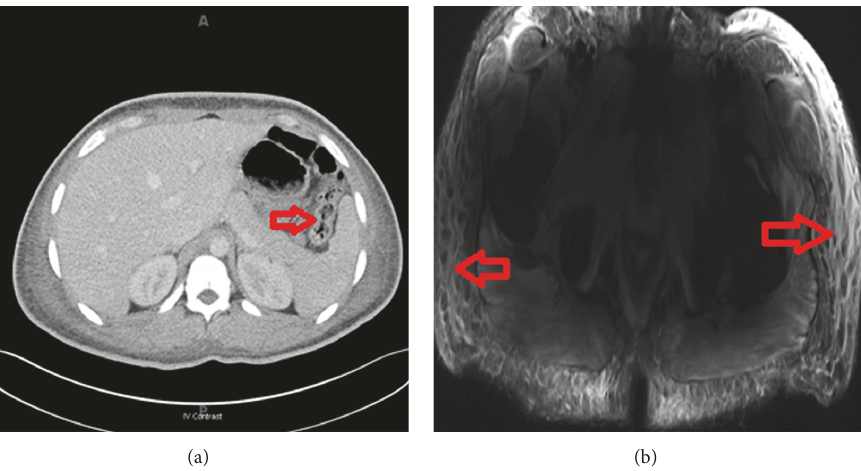
Figure 2: (a) CT of the abdomen showing thickening of the bowel wall (red arrow). (b) MRI showing edema of the soft tissue (red